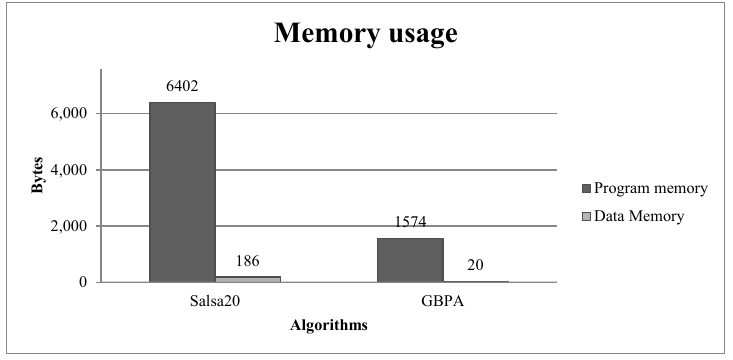
Figure 2. Memory footprint comparison between GBPA and